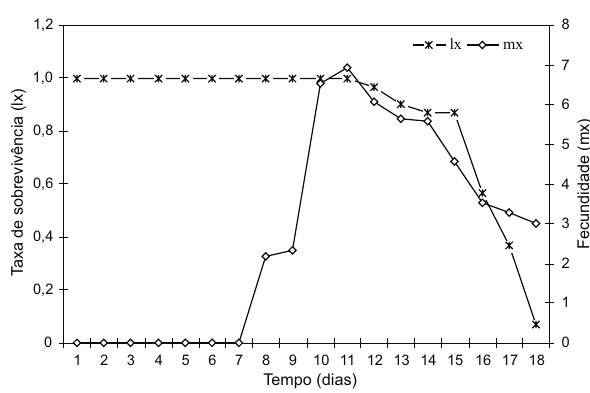
Figura 2. Taxa de sobrevivência e número de descendentes/fê- mea/dia de T. desertorum criados em folhas de feijão ( P. vulgaris ) cultivar “Tacarigua” a 28 ± 2ºC, 70 ± 10% U.R. e 12:12 h, em